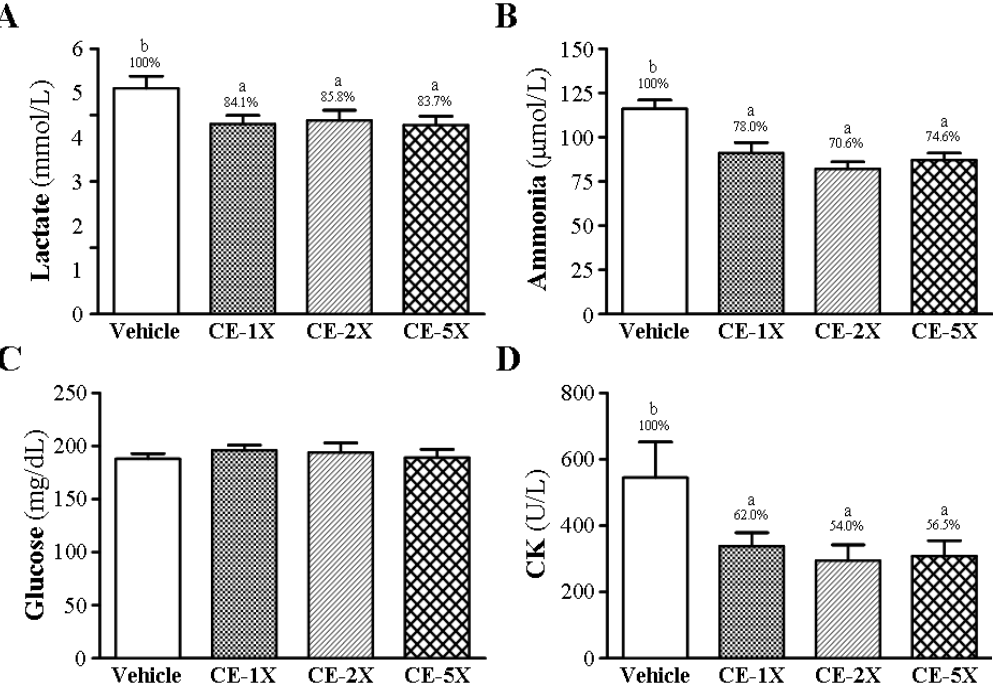
Figure 3. Effect of 4-week CE supplementation on serum levels of lactate ( A ); ammonia ( B ); glucose ( C ) and creatine kinase (CK) ( D ) after a 15-min swimming exercise challenge. Data are mean ± SEM for n = 10 mice per group. Bars with different letters (a, b) are significantly different at p < 0.05. Percentages above bars show percentage of